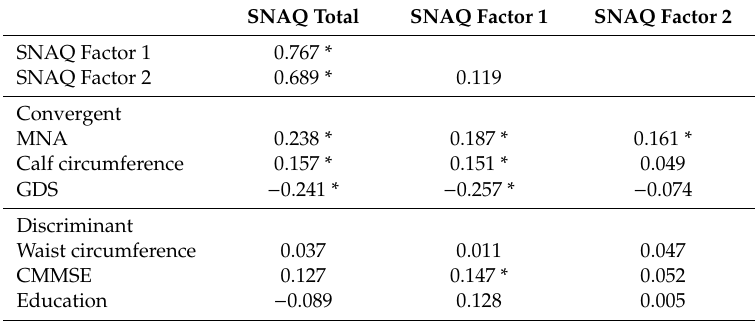
Table 4. Convergent and Discriminant Validity of